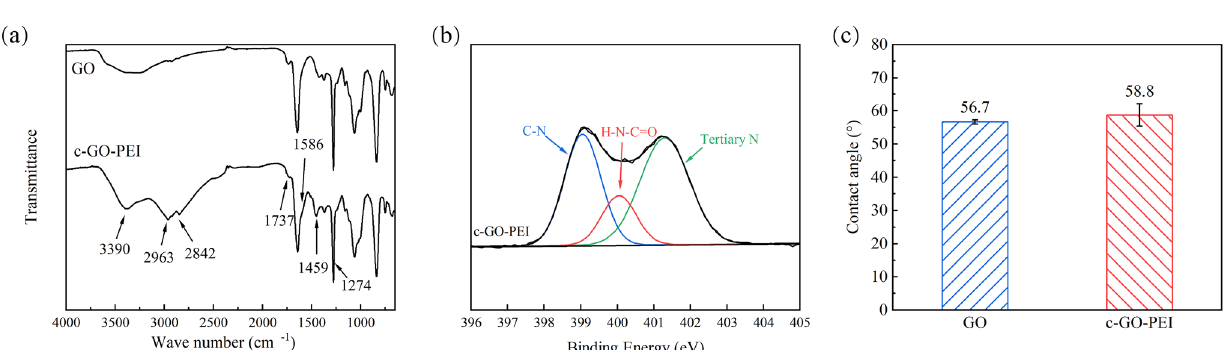
Fig. 3 a FTIR spectra of GO and c-GO-PEI membranes, b XPS N1s fitting curve of c-GO-PEI membrane and c water contact angles of GO and c-GO-PEI